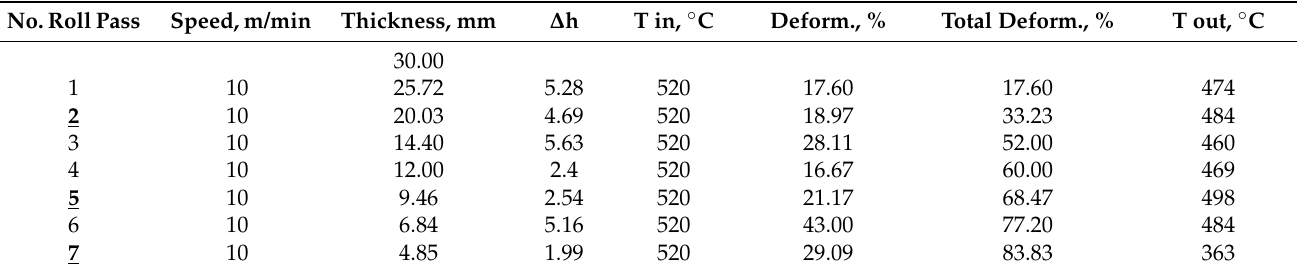
Table 2. Actual rolling parameters of 5182 alloy.